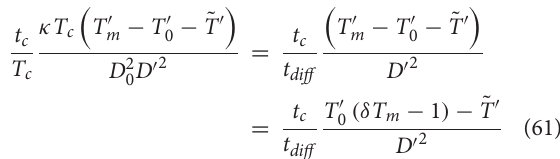
has to be multiplied with t c / T c for non-dimensionalization.